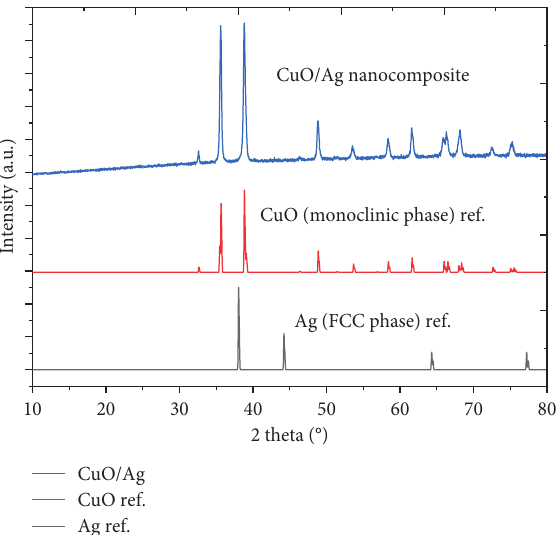
Figure 1: XRD spectrum of CuO/Ag correlated with the reference data of CuO monoclinic phase and the face centered cubic (FCC) phase of Ag.